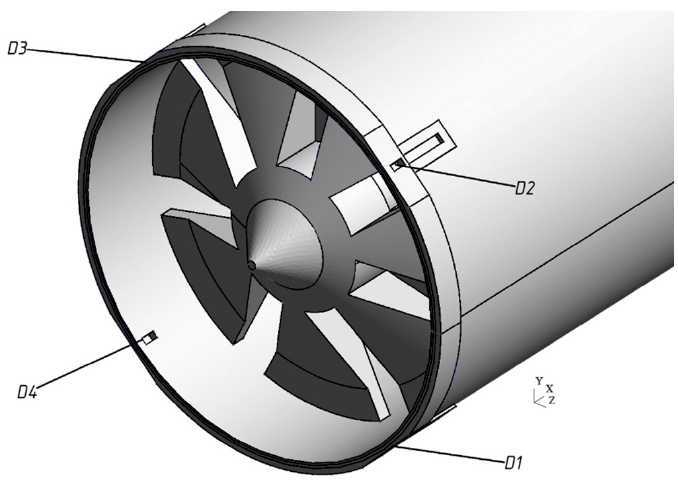
Figure 8. Arrangement of magneto-sensitive elements in cutting edge grooves of the shield housing. redistribution and increase in local magnetic flux density in the area of the ferroprobe location by 10–15% (Figure 9).